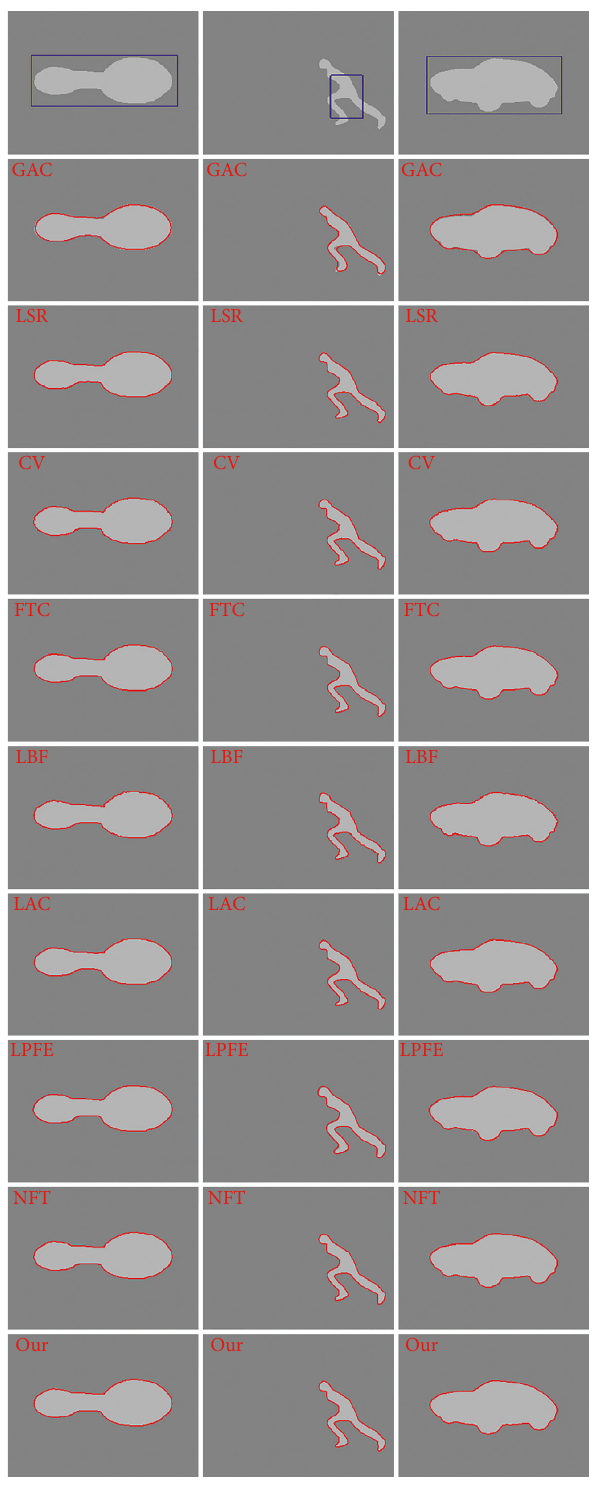
Figure 7: The test images for convergence rate comparison experiments.